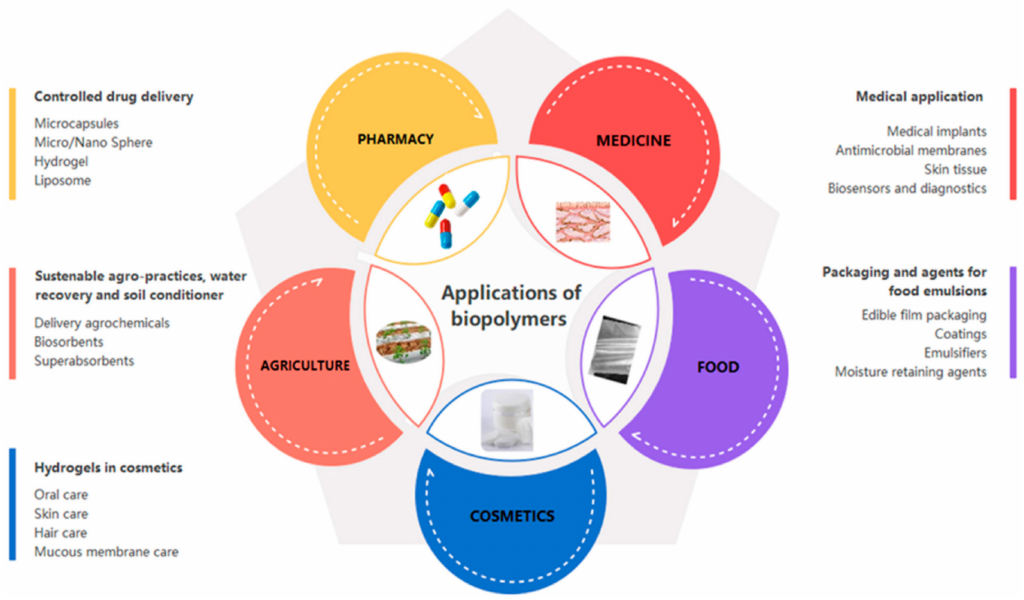
Figure 2. Applications of biopolymers. Reprinted from ref.